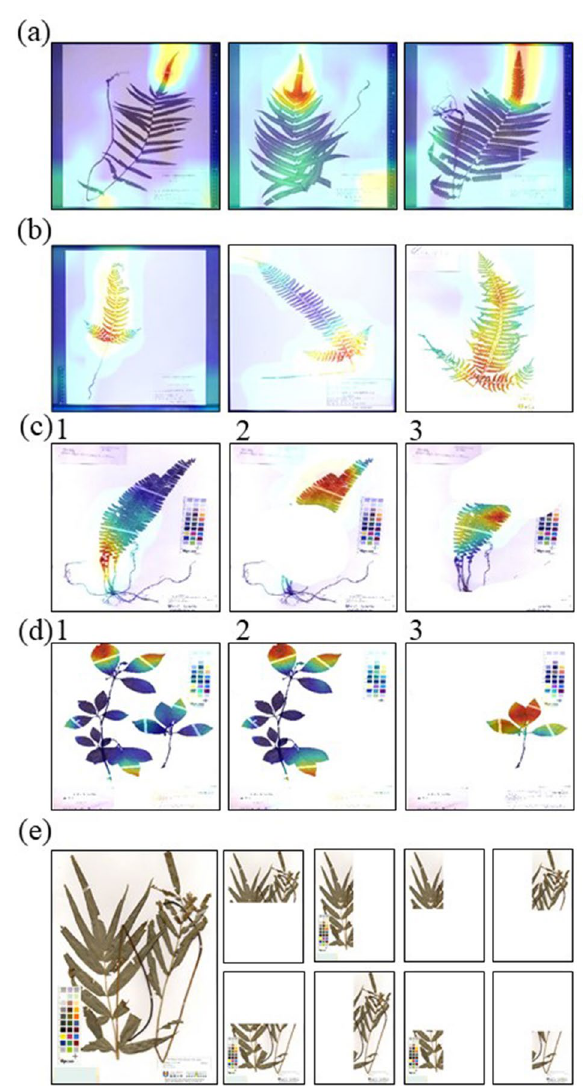
Figure 5. Results of Grad-CAM analysis of ( a ) Thelypteris acuminata (Houtt.) C.V. Morton and ( b ) Polystichum tripteron (Kunze) C. Presl. ( c ) In the Grad-CAM analysis, only part of the specimen was considered important (red). ( c 2) Images in which the focal part was cut out and ( c 3) images in which only the non-focal part was cut out were created and used for Grad-CAM analysis. ( d 1) Multiple individuals in one specimen image. The image was divided into two images ( d 2, 3) and used for Grad-CAM analysis. ( e ) The sample image was halved vertically and horizontally, and further divided it into four both vertically and